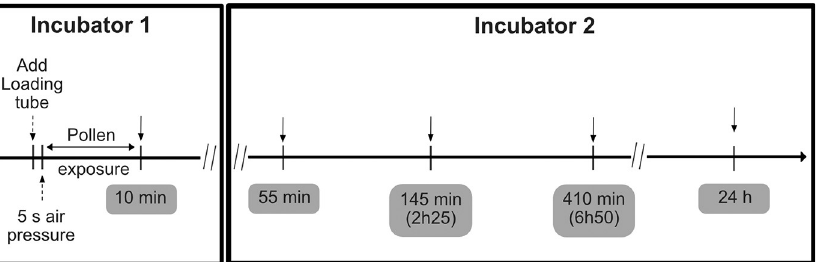
Fig 2. Experimental design of dosing pollen on BEAS-2B cells at ALI. Incubator 1 contained the complete Pollen- ALI where the pollen was dosed to the cells. Pollen sedimentation was completed after 10 min and the exposed cells were transferred into a second incubator and kept at ALI conditions for the indicated times. Both incubators were at 37˚C and 5% CO 2